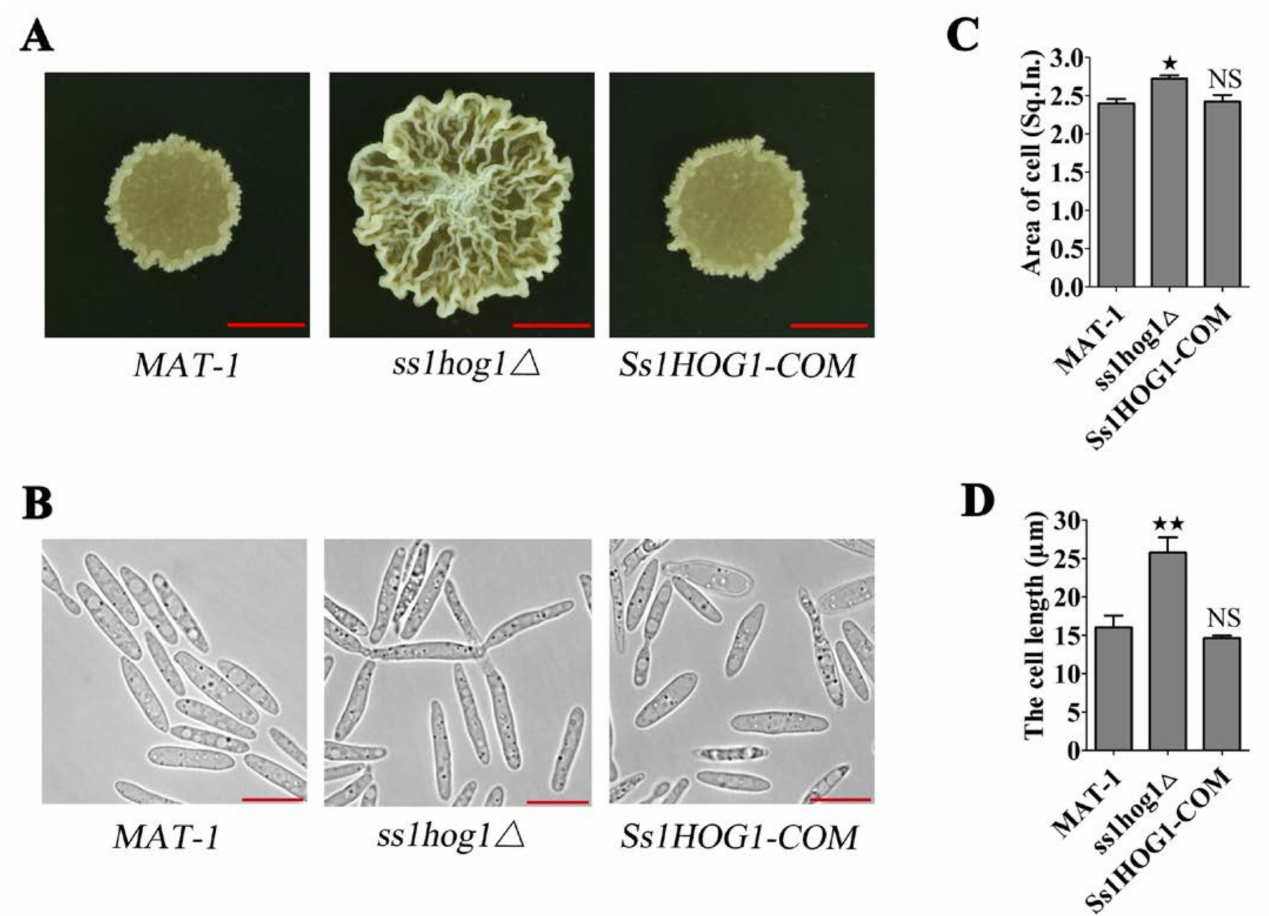
Figure 2. Effects of SsHog1 on morphology of S. scitamineum . ( A ) The colony morphology of MAT-1 , ss1hog1 ∆ , and Ss1HOG1-COM strains. The fresh haploid sporidia were spotted onto YePSA medium at 28 ◦ C. Images were taken 4 days after cultivation. Scale bar = 5.0 mm. ( B ) The microscopic morphology of MAT-1 , ss1hog1 ∆ , and Ss1HOG1-COM strains. MAT-1 , ss1hog1 ∆ , and Ss1HOG1-COM haploid sporidia were allowed to grow till O.D. 600 = 1.0, and then 5 µ L of the sample was mounted on the slide and observed. Images were taken by Leica DMI8 Inverted Fluorescence Microscope. Scale bar = 10 µ m. ( C ) The cell areas of MAT-1 , ss1hog1 ∆ , and Ss1HOG1-COM strains were measured. MAT-1 , ss1hog1 ∆ , and Ss1HOG1-COM haploid sporidia were allowed to grow till O.D. 600 = 1.0, and then images were taken by Leica DMI8 Inverted Fluorescence Microscope. Adobe Photoshop software was used to calculate the pixels of each cell. One square inch (Sq. In.) is 72 by 72 pixels. (cid:70) p Bar chart depicts statistical difference between the mean values ( < 0.05). NS denotes a not statistically significant difference ( p < 0.05). The sample was independently performed with three independent biological repeats, each of which contained twenty replications. ( D ) The cell lengths of MAT-1 , ss1hog1 ∆ , and Ss1HOG1-COM strains were measured. The fresh haploid sporidia were allowed to grow till O.D. 600 = 1.0, and then images were taken by Leica DMI8 Inverted Fluorescence Microscope and the length of the cell was measured. The unit is µ m. Bar chart depicts statistical (cid:70)(cid:70) p difference between the mean values ( < 0.01). NS denotes a not statistically significant difference ( p < 0.05). The sample was independently performed with three independent biological repeats, each of which contained twenty